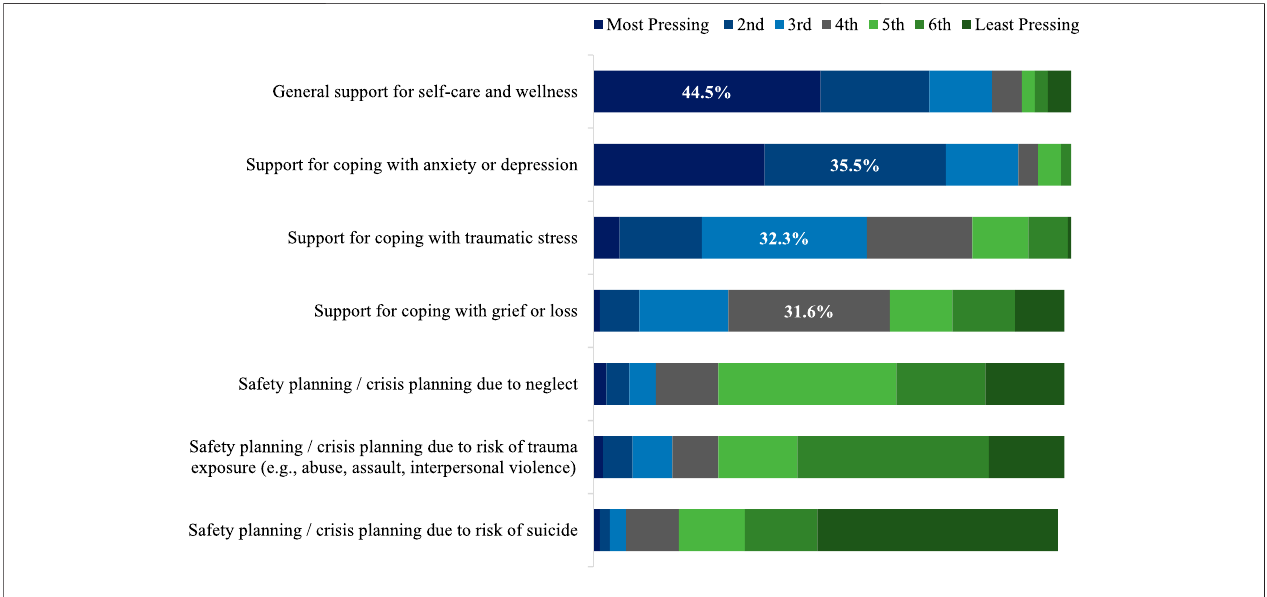
FIGURE 2 | Students ’ most pressing mental health needs as perceived by school mental health professionals. Note :Surveyquestion: “ Whatdoyoubelievearethemostpressingmentalhealthneedsofyourstudentsrightnow?[Draganddroptorearrangetheitemsbelow,placing them in order from: 1 (cid:1) most pressing concern to 7 (cid:1) least pressing concern] ” N (cid:1) 155; No responses (cid:1)